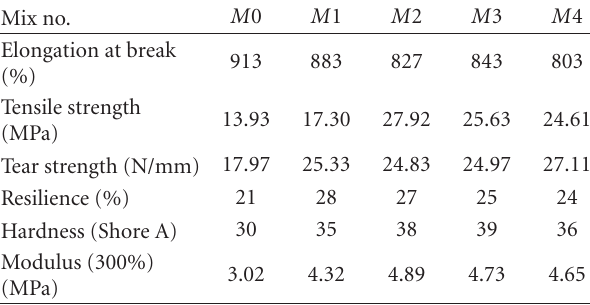
Table 2: Mechanicals properties of vulcanized NR.